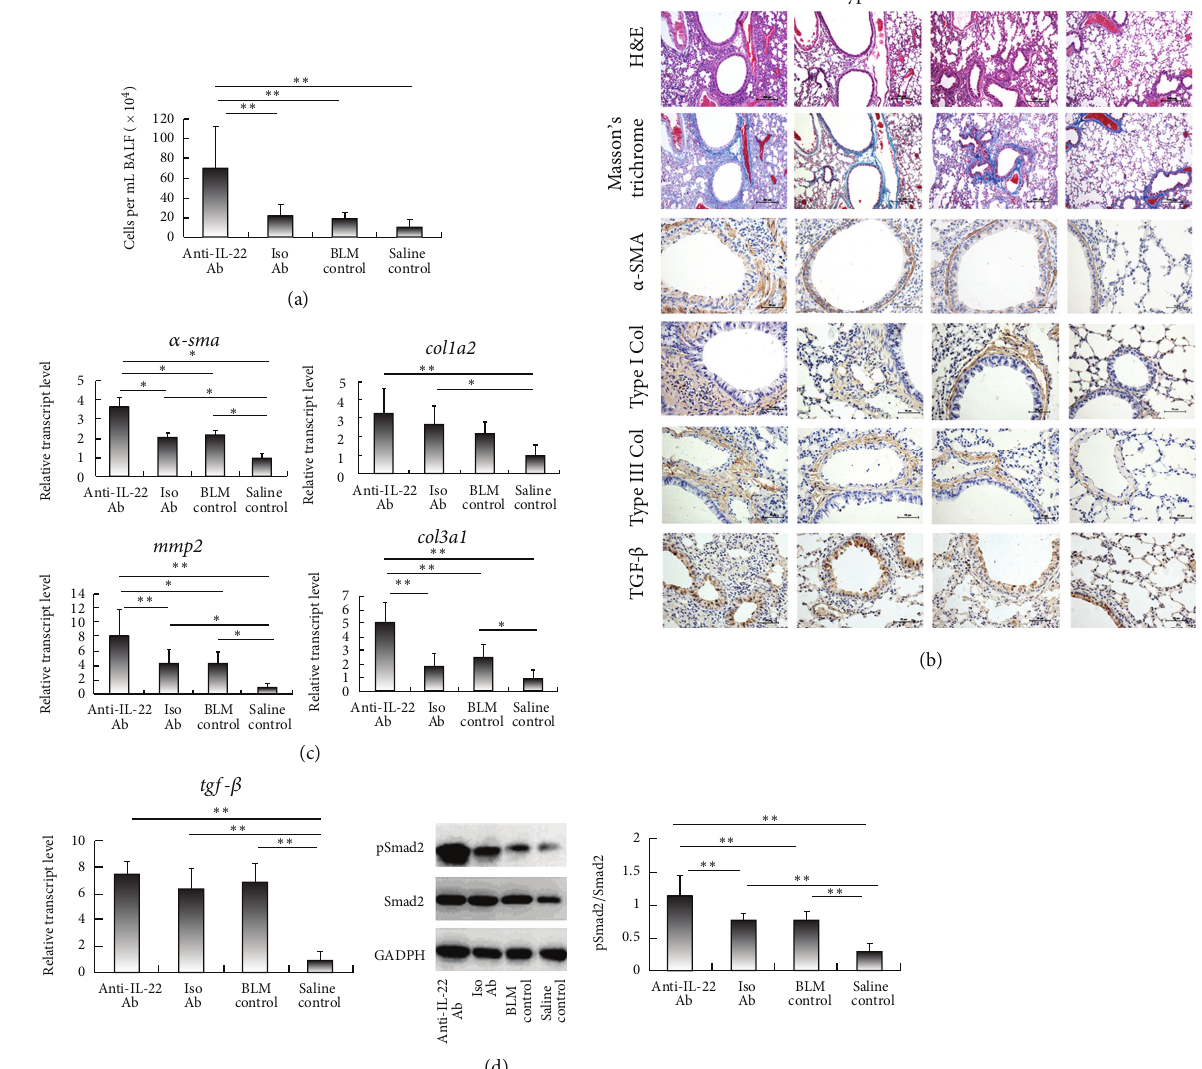
Figure 5: Administration of anti-IL-22 neutralizing antibody enhances BLM-induced pulmonary inflammation and fibrosis. Mice were induced with once bleomycin (BLM) in combination with intraperitoneal injection of anti-IL-22 neutralizing antibody (Anti-IL-22 Ab) or isotype antibody (Isotype Ab) for two consecutive weeks, as compared with BLM-treated mice (BLM control) and saline-treated mice (saline control) without any administration followed. (a) Cell counts of lymphocytes from bronchoalveolar lavage fluid (BALF) were shown. (b) Representative photomicrographs of lung sections were stained with hematoxylin and eosin (H&E) or with Masson’s trichrome, as well as by immunohistochemistry for anti- 𝛼 -smooth muscle actin ( 𝛼 -SMA), anti-collagen I (Col I), anti-collagen III (Col III), and anti-transforming growthfactor(TGF)- 𝛽 antibody.Bars = 200 𝜇 m(forH&EandMasson’strichromestaining),or50 𝜇 m(forimmunohistochemistry).(c)Levels of transcripts for 𝛼 -sma , col1a2 , col3a1 , and tgf- 𝛽 in the lungs were measured by real-time reverse transcription-polymeras chain reaction (RT- PCR) analysis, normalized to that of saline-treated mice. (d) Level of transcript for tgf- 𝛽 in the lungs was assessed as described in Figure 4(c) (left).ProteinlevelsofphosphorylatedSmad2(pSmad2),totalSmad2,andGADPHinlunghomogenatesweredeterminedbywesternblotting (middle). Densitometry was performed, and fold increase in pSmad2 expression after normalization to total Smad2 expression was shown (right). Values in (b), (c), and (d) are the mean and SEM of 5 to 9 mice per group from at least two separate experiments. ∗ 𝑃 < 0.05 ; ∗∗ 𝑃 < 0.01